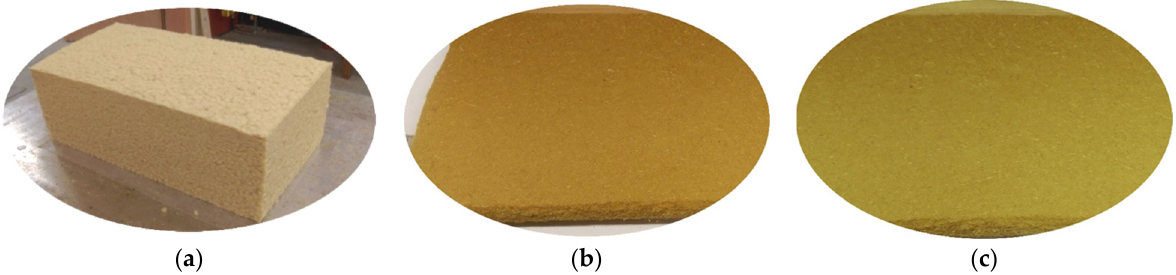
Figure 1. ( a ) The view of the mold before pressing. ( b , c ) The view of the board after pressing at ( b ) 180 °C and ( c ) 150 °C.